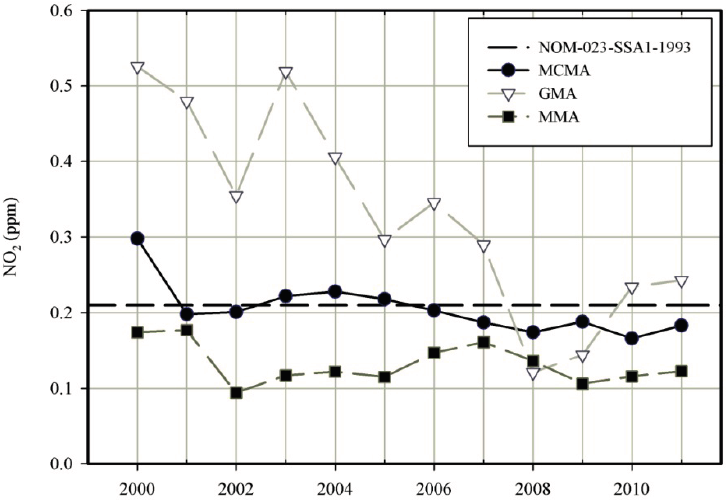
Figure 8. Maximum values of 1-h averages of NO metropolitan areas. The dashed horizontal line indicates the maximum permissible limit (MPL) in